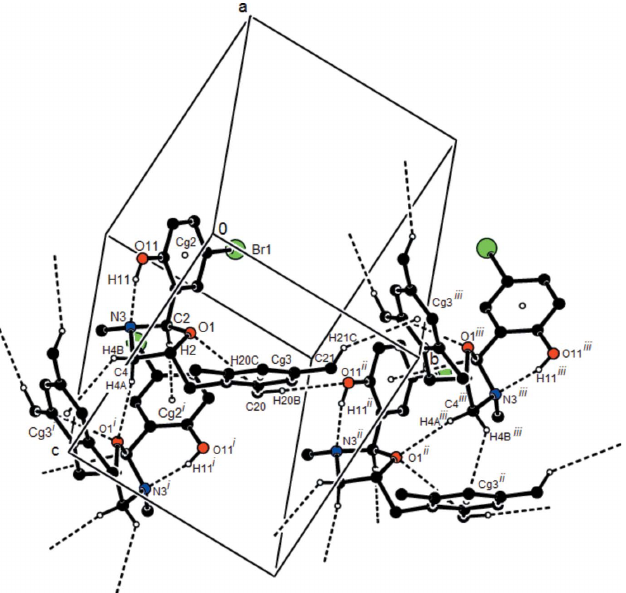
Figure 3 A general view of the C—H (cid:3)(cid:3)(cid:3) O hydrogen bonding and C—H (cid:3)(cid:3)(cid:3) (cid:2) interactions of the title compound. Symmetry codes: (i) x , (cid:5) y + 1 x , y + 1, z ; (iii) x , (cid:5) y (cid:5) 1